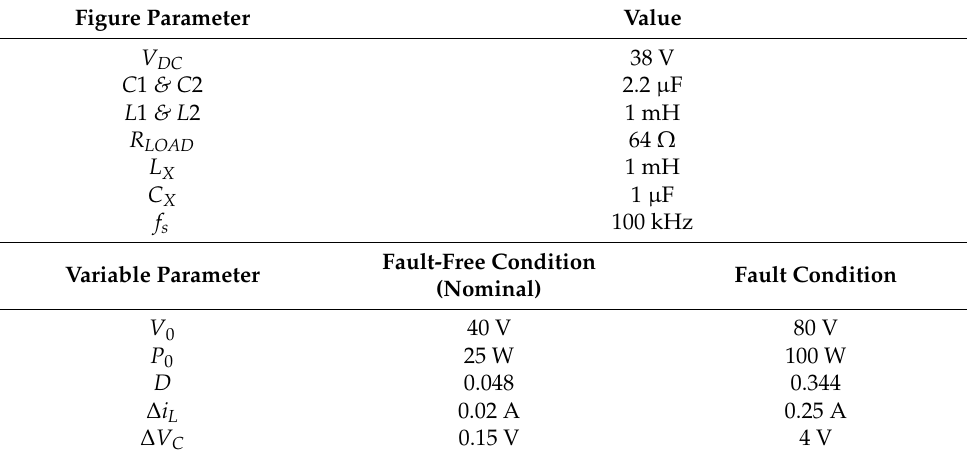
Table 2. Z-source converter design parameters. Figure